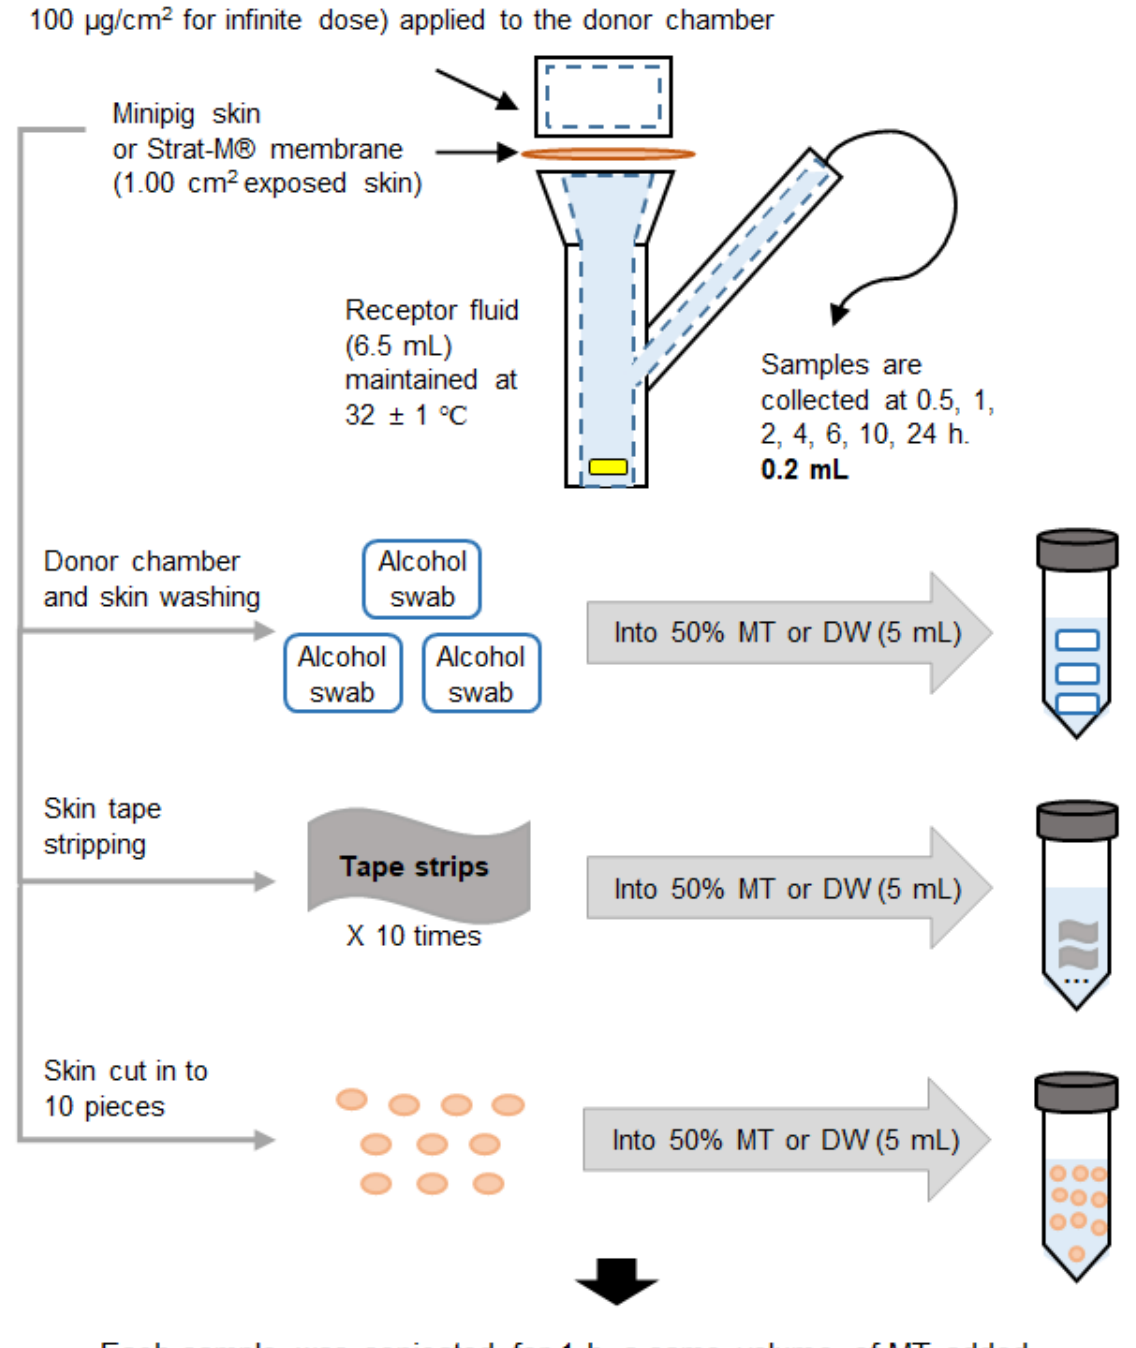
Figure 1. Schematic diagram of percutaneous absorption study by Franz cell. BIT, benzisothiazoli- none, MT, methanol, DW, distilled water.